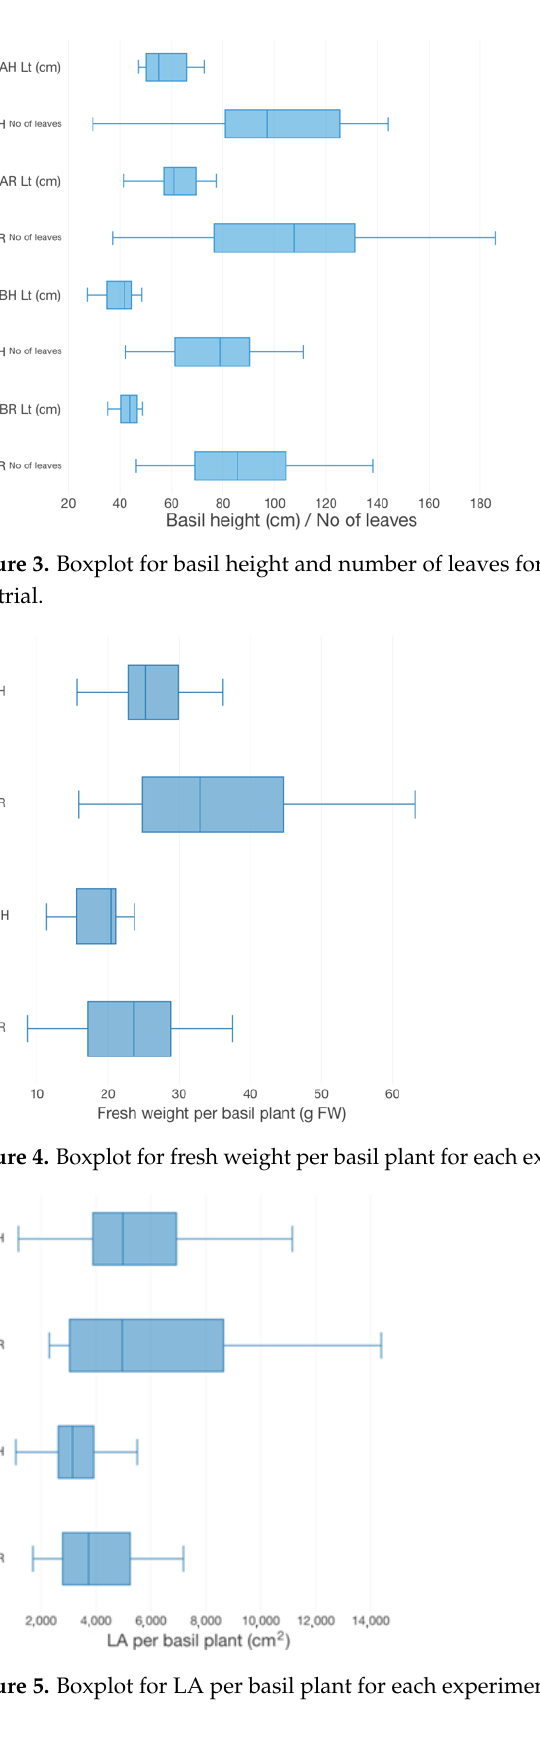
Figure 5. Boxplot for LA per basil plant for each experimental variant, at the end of the trial.